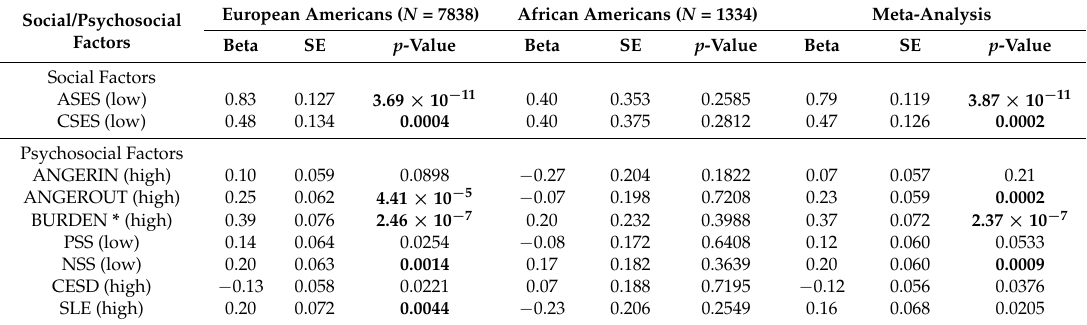
Table 2. Association between social/psychosocial factors and body mass index (BMI) from longitudinal analysis using generalized estimation equation models in the Health and Retirement Study (HRS). European Americans ( N = 7838) African Americans ( N = Social/Psychosocial Factors